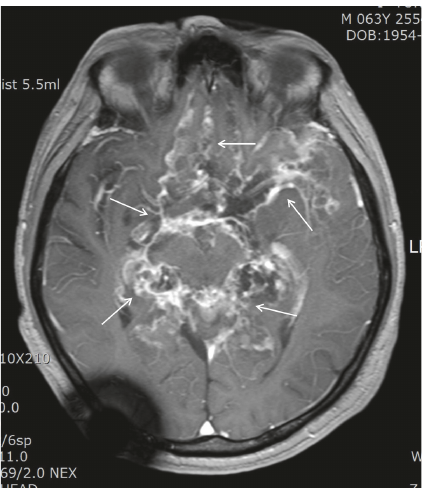
(c) Prominent leptomeningeal enhance- ment is noted in the basal, interhemi- spheric, and left sylvian cisterns in an enhanced T1-weighted axial MRI image at the time of recurrent mental confusion (January 2017). No intra-axial enhancing lesion is observed